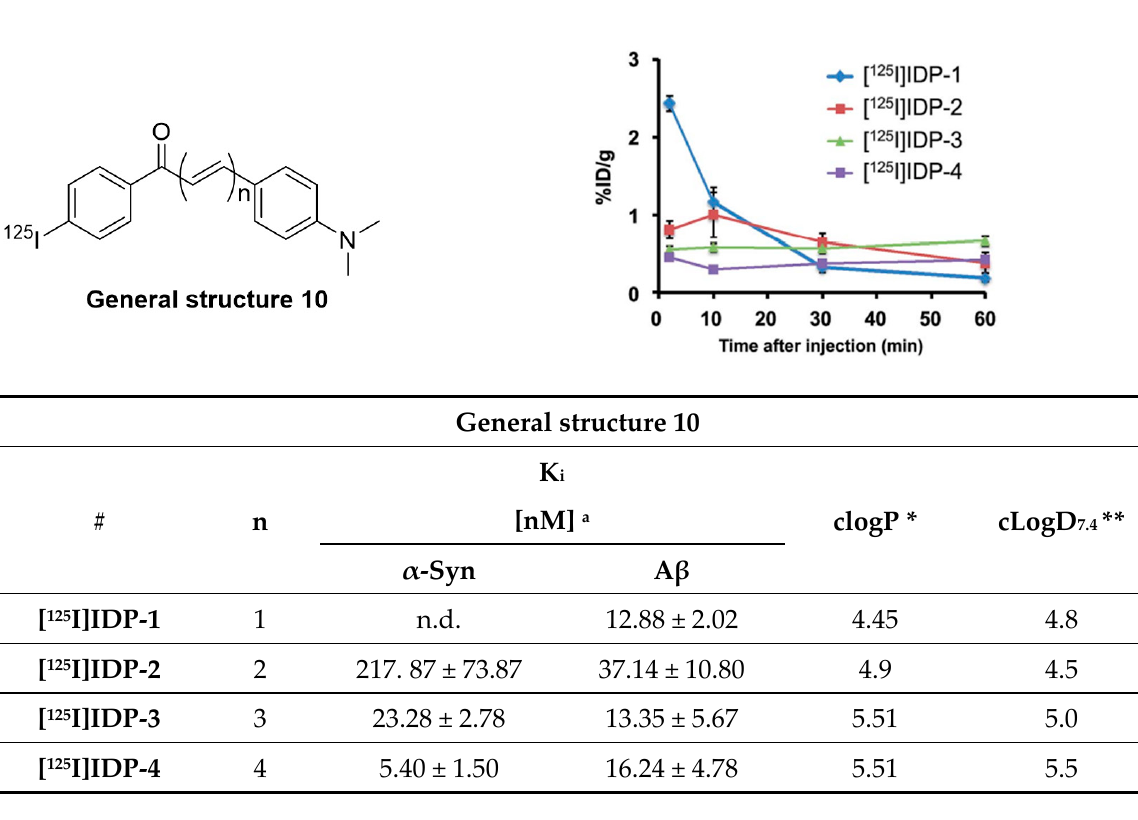
Figure 21. Chemical structure of radioiodinated diphenyl derivatives and brain uptake of radioactivity after intravenous injection. Binding affinity values are determined for recombinant α -syn and A β fibrils. Reprinted with permission from Ono et al. [132]. Copyright 2016 Royal Society of Chemistry. * clogP values were calculated by BioByte. ** clogD 7.4 values calculated by ACD/Percepta.